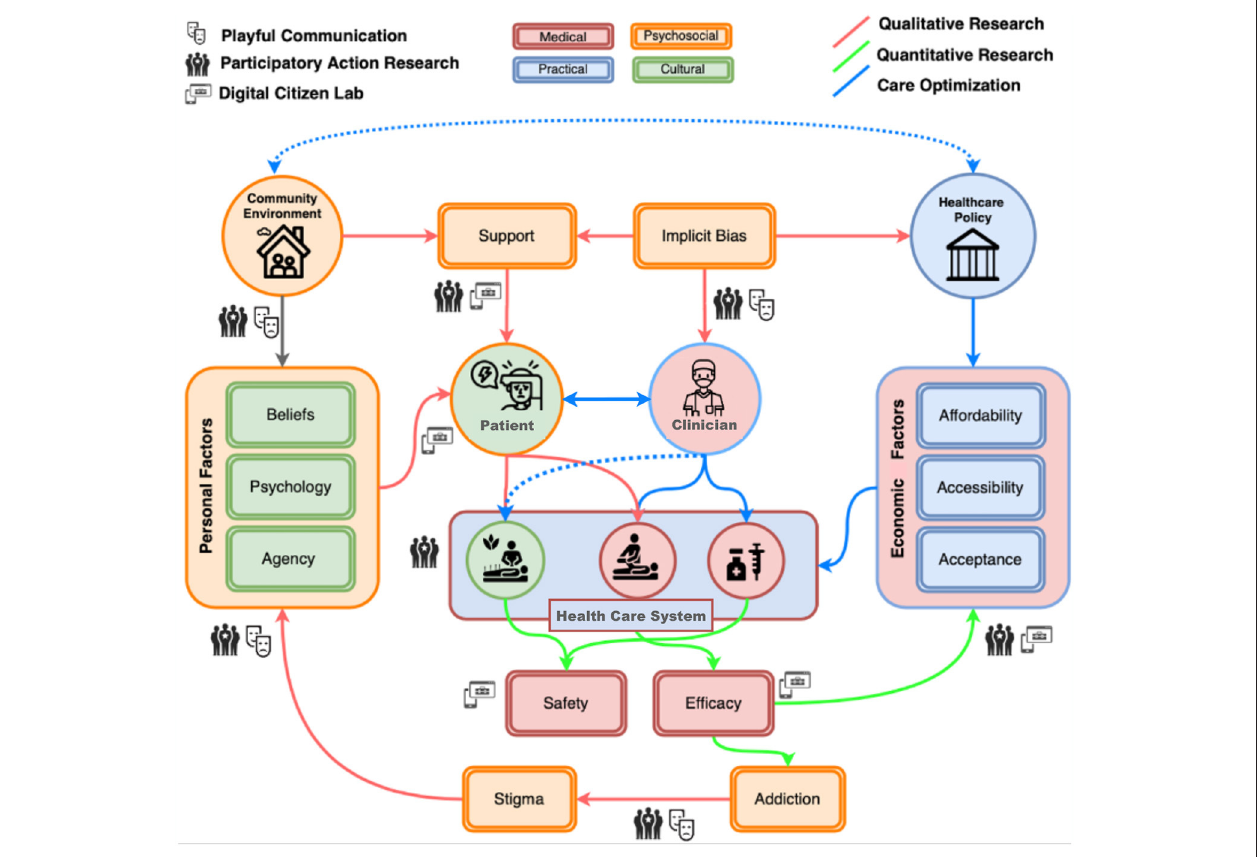
FIGURE 2 | An extended cybernetic model for pain research. This diagram represents potential sites for data collection in the system of relationships between factors that govern the interaction of an individual patient and the health care system. Variables that relate to patients (indicated in green) include personal experiences and expressions of pain, as well as individual beliefs, psychological traits, and behaviors that express patients’ agency, e.g., their treatment preferences and choices. Variables that relate to medical professionals (in pink) include the availability of evidence-based treatments with established safety and efficacy, and economic factors that affect the availability of services. Cultural contexts influence psychosocial factors (in orange) and reflect individuals’ personal history and the community and wider social contexts in which they live. Social factors such as support systems, the implicit biases of healthcare institutions, and stigma (e.g., due to the perceived risk of addiction to opioid analgesics) influence individuals’ pain experience and interactions with the health care system. Healthcare policy (in blue) influences the availability of care options (complementary and alternative, non-pharmacological, and biomedical) by determining their affordability, accessibility and acceptability. Different research methodologies can be deployed to investigate the interactions between these variables, including: quantitative data collection through a digital interface (indicated by a screen icon), e.g., analgesic efficacy and safety, cost, and availability of support; participatory action research (community icon), e.g., the study of stigma, community factors, implicit biases or economic factors; and play (theater masks icon) which can provide a flexible frame for studying interactions that are not captured by conventional research